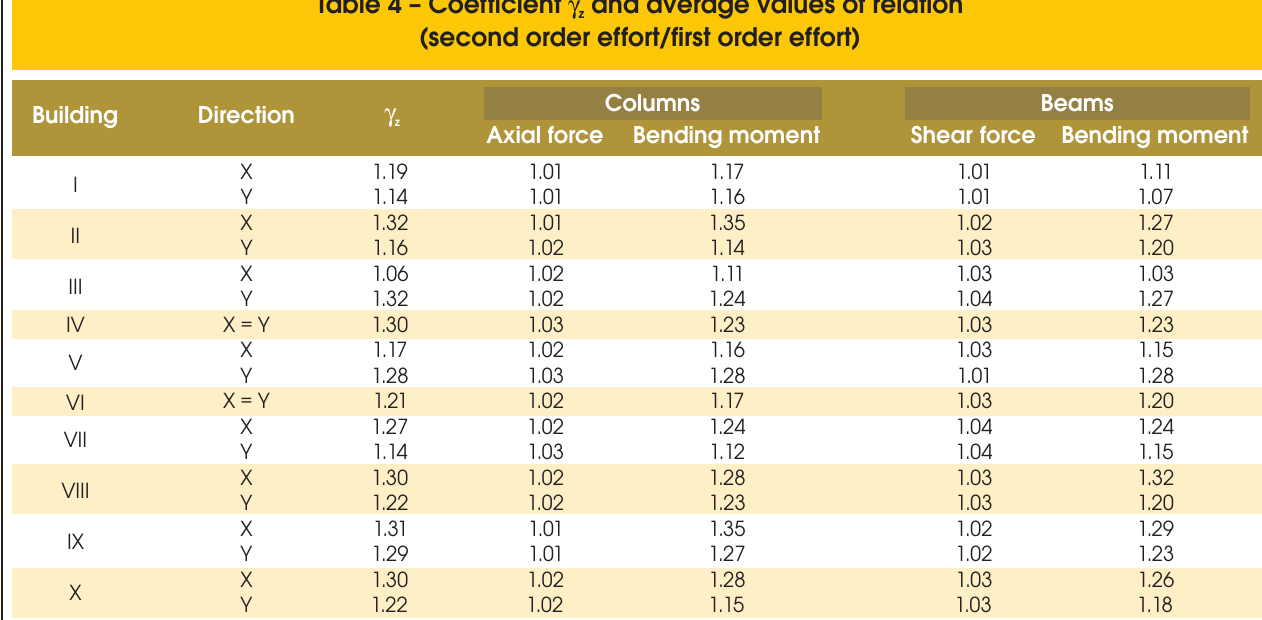
Table 4 – Coefficient g and average values of relation z (second order effort/first order